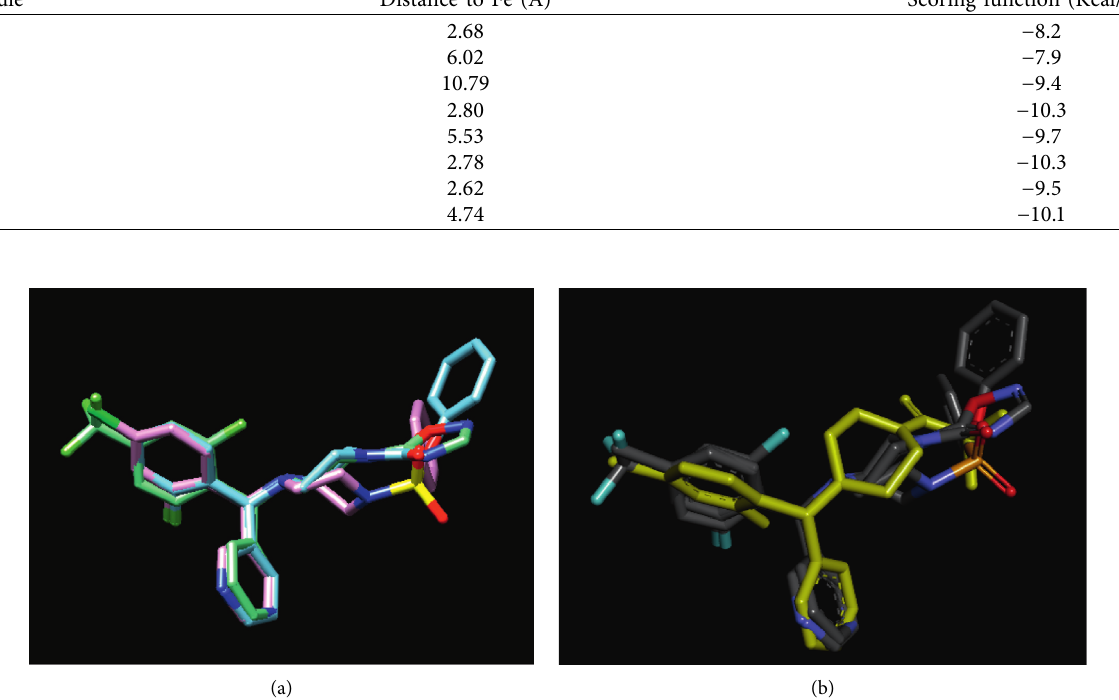
Figure 6: (a) Superposed conformations of molecules 18( S ) (violet), 33( S ) (pale green), and 45( S ) (blue). (b) Superposed conformations of molecules 3( R ) (yellow), 18( S ), 33( S ), and 45( S ) in conventional atom color codes of the Discovery Data